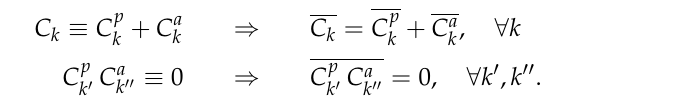
Figure 1. Sketch of a cut of a plume of volume V p inside a CTM cell of volume V centered at x : C p C a are the concentrations of a species k according to Equation k